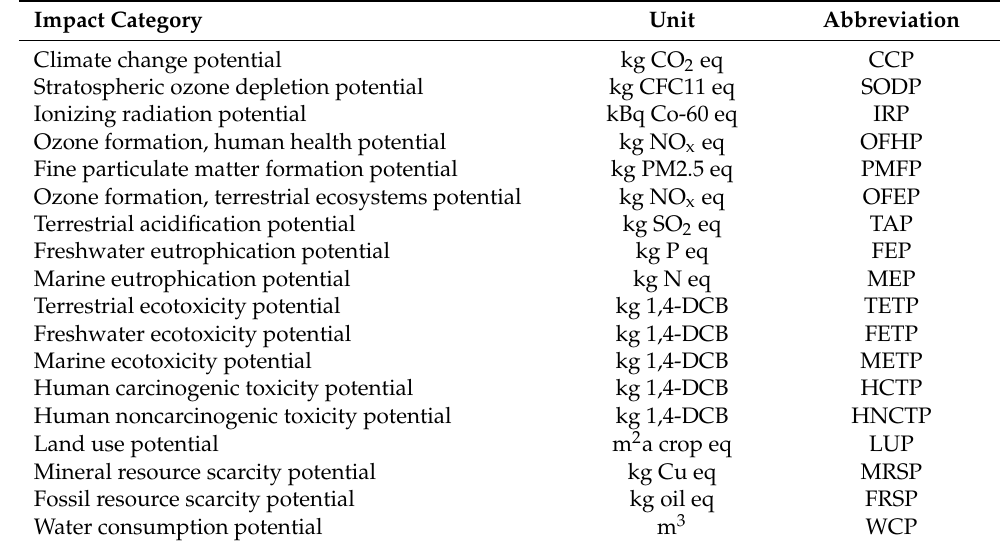
Table 2. LCA midpoint indicators and related